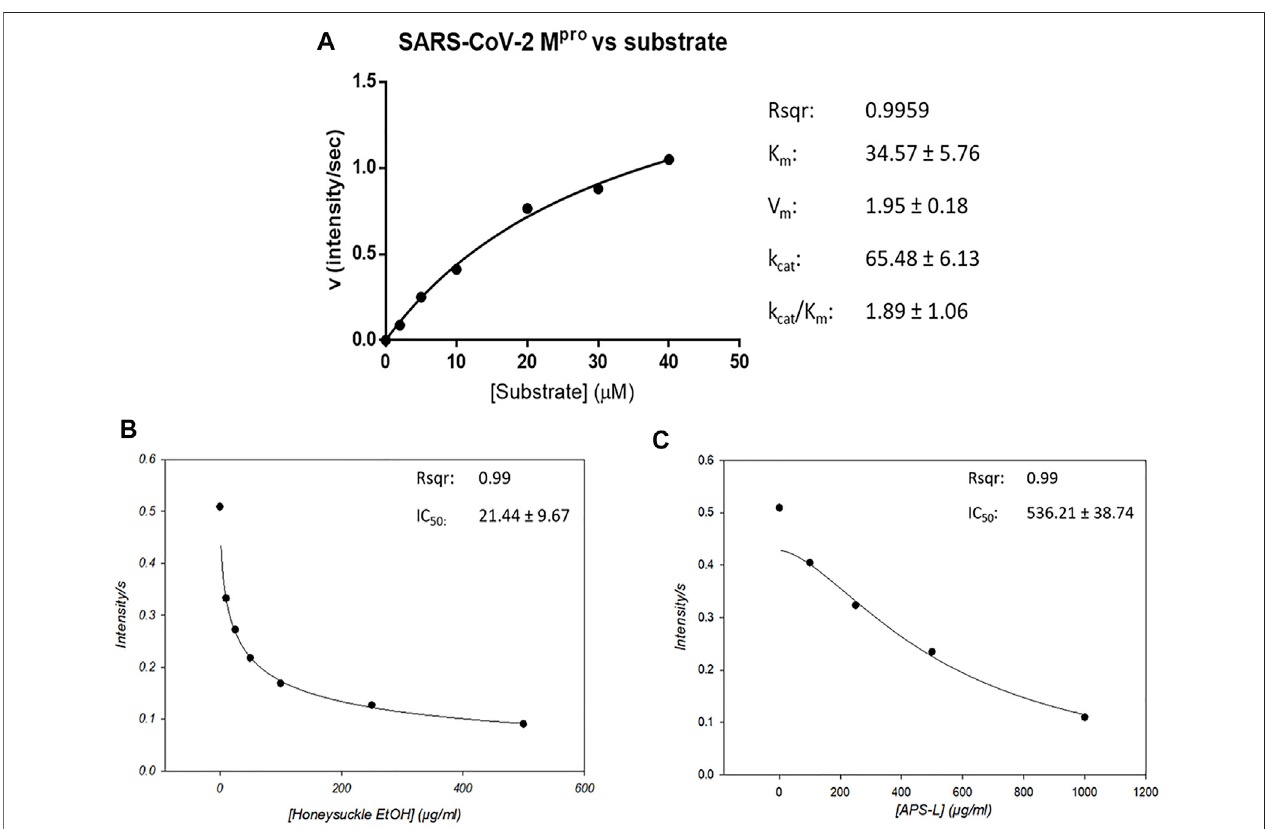
FIGURE 6| Honeysuckle and APS-L inhibit SARS-CoV2 M pro activity. (A) Activity ofSARS-CoV-2 M pro in the presence ofa peptide substrate, a fl uorogenic probe (Abz-TSAVLQSGFRK-Dnp).Theconcentrationsofthepeptidesubstratevariedfrom2to40 µMinPBSbuffer,whileM pro concentrationwas fi xedat0.12 µM.Theeffect of honeysuckle-EtOH (B) and APS-L (C) on SARS-CoV-2 M pro activity was investigated. The IC 50 value for each reaction was calculated and displayed.